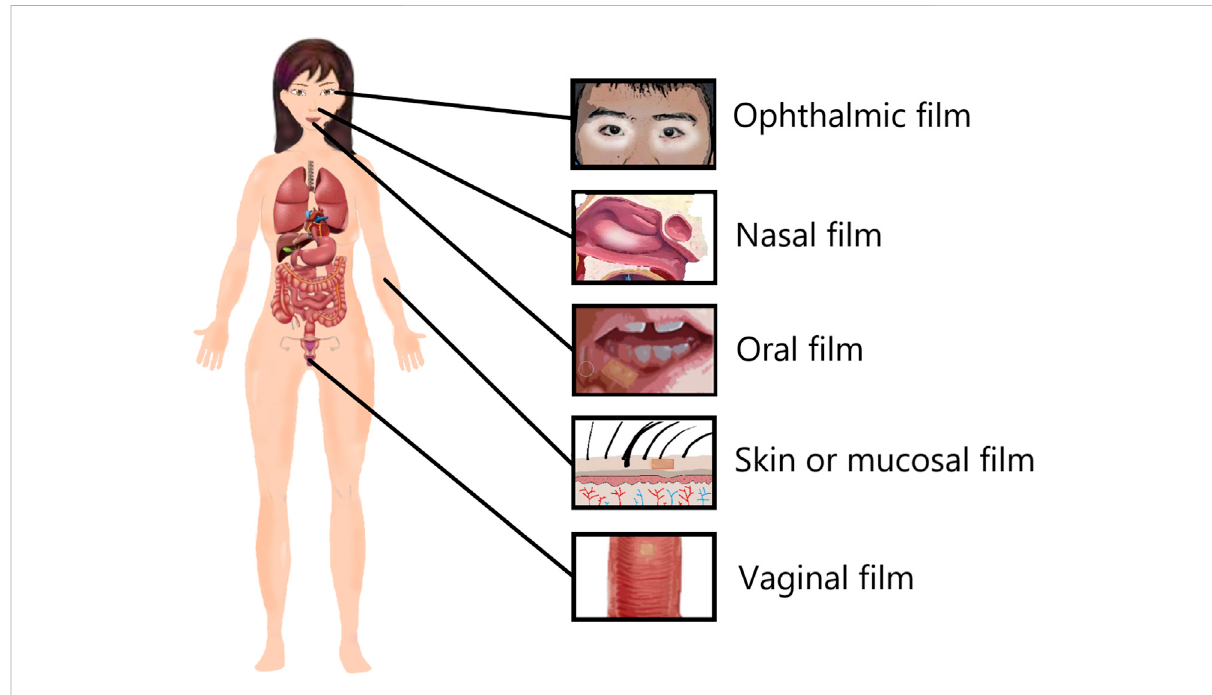
FIGURE 2 Classi fi cation of patch fi lm